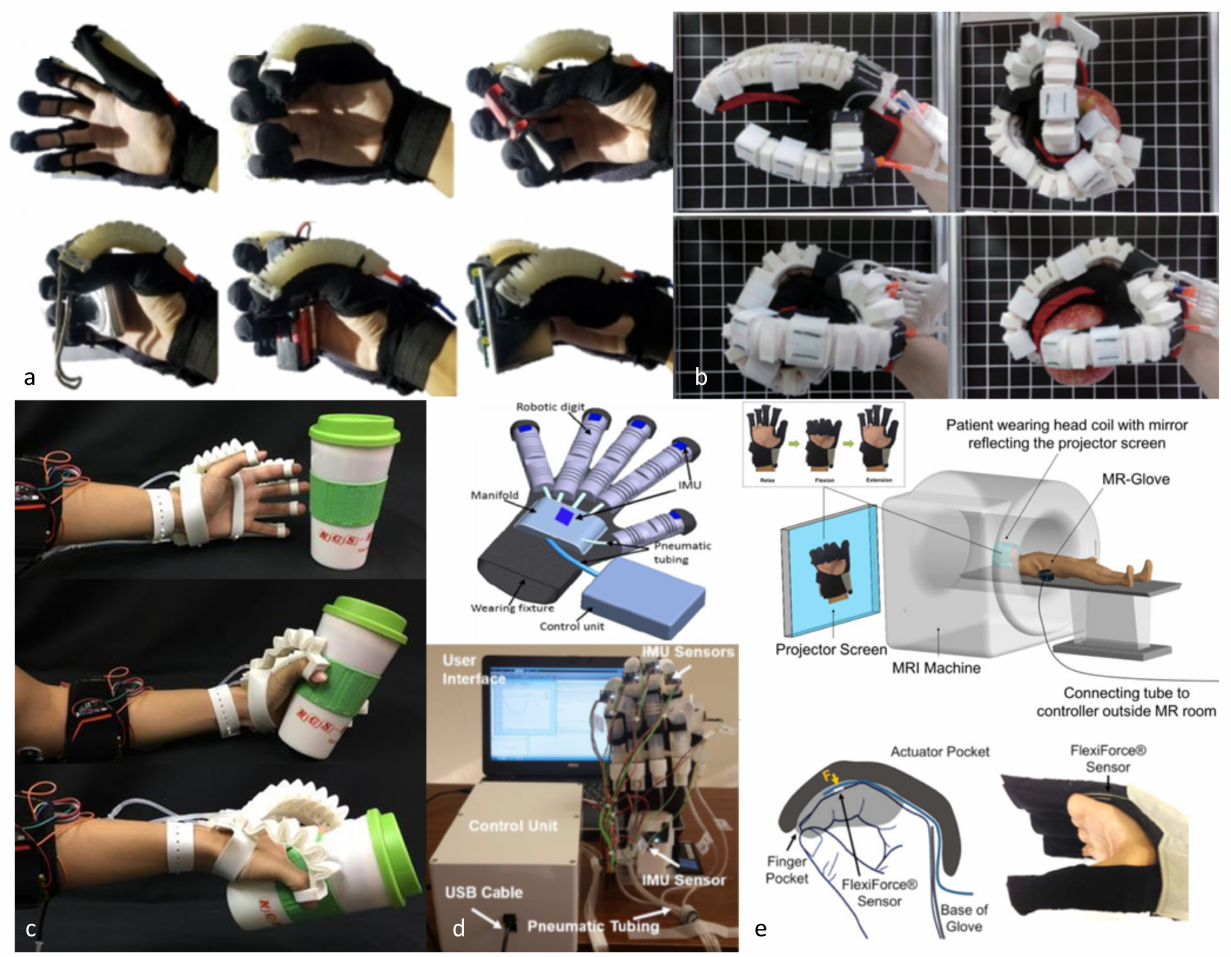
Figure 20. Soft gloves for Rehabilitation or Assistance. ( a ) PneuNets based glove developed by Do et al. [25]. Reprinted/adapted with permission from Ref. [25]. 2021, IEEE. ( b ) Segmented Pne- uNets glove developed by Wang et al. [52]. Reprinted/adapted with permission from Ref. [52]. 2019, IEEE. ( c ) The PIY (Print-It-Yourself) soft glove of Ang and Yeow [43]. Reprinted/adapted with permission from Ref. [43]. 2017, IEEE. ( d ) Sensorized soft robotic glove based on pneumatic soft-and-rigid hybrid actuators for providing continuous passive motion in hand rehabilitation